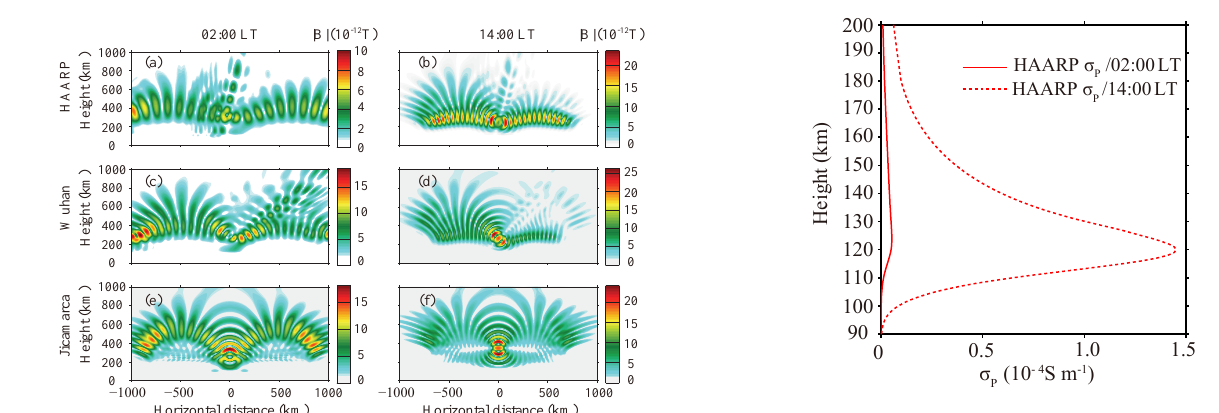
Figure 7. The magnitude of total magnetic field vector of the artifi- cially generated ULF wave at t = 2 . 0s in a simulation. The modu- lated HF heating is conducted in the ionosphere at HAARP, Wuhan and Jicamarca at 02:00LT and 14:00LT, and the modulation fre- quency is 4.0Hz.